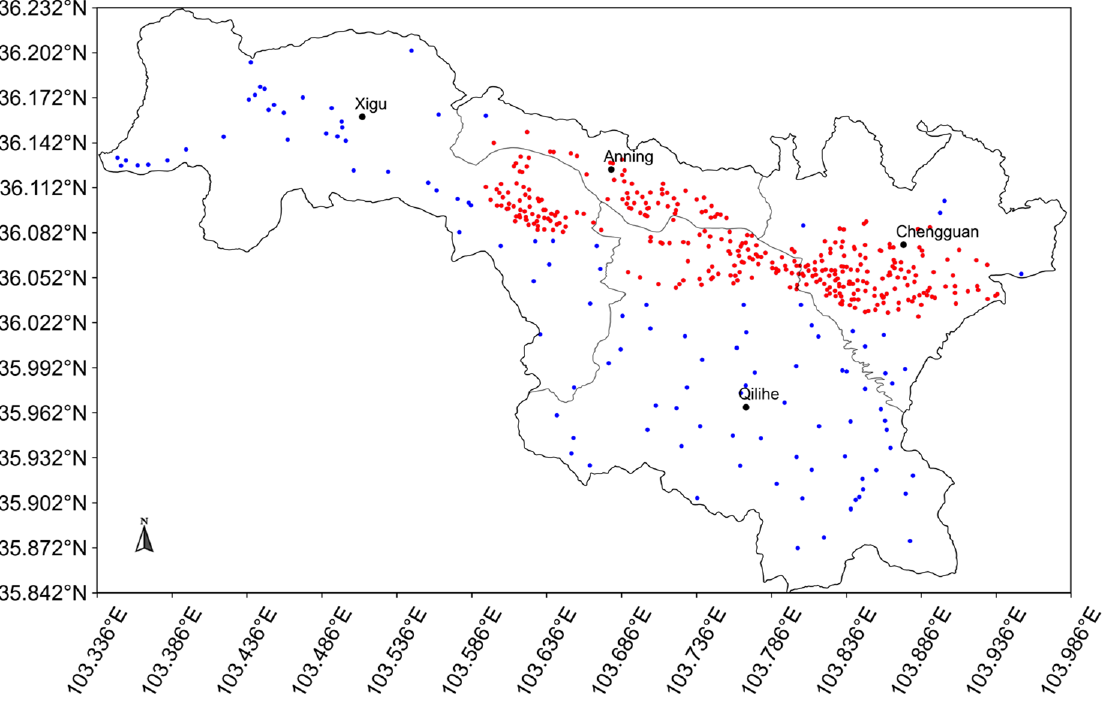
Figure 1. Study area and the distribution of micro stations in Lanzhou City, China, where the red dots represent the stations in the core area.